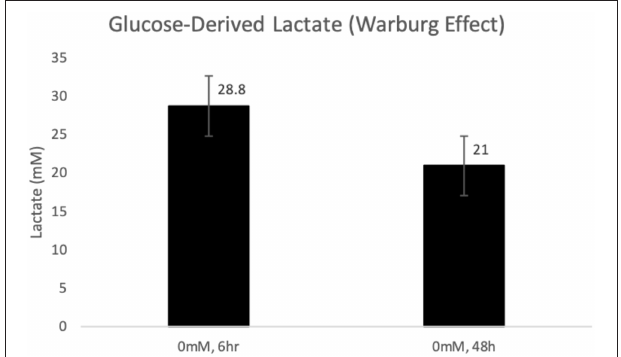
FIGURE 1 | Glucose-derived lactate (Warburg Effect) in MCF-7 cells after 6 and 48h of incubation in glucose ( p < 0.001).